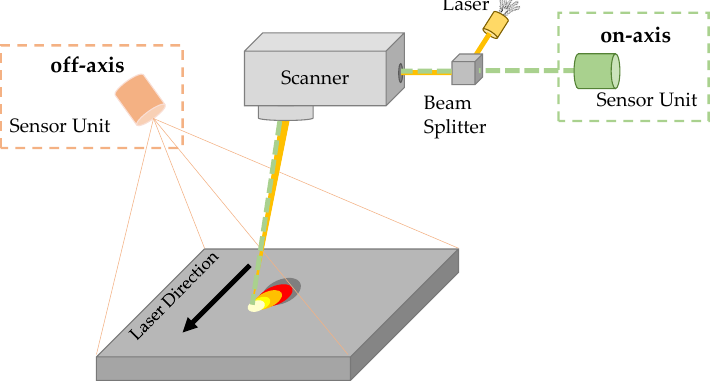
Figure 2. Schematic representation of the differently arranged sensor units of on-axis and off-axis systems.